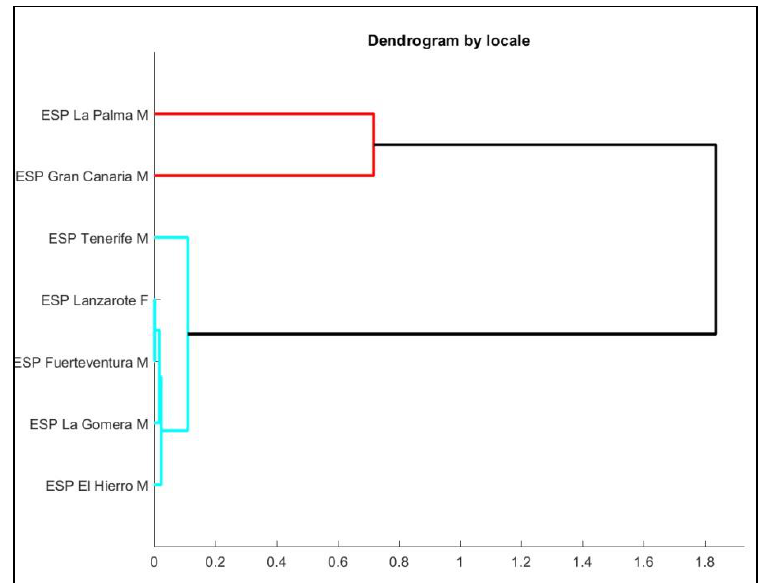
Figure 4. Dendrogram of SVO declarative sentences by areas (vertical axis) and distance values along the horizontal axis.